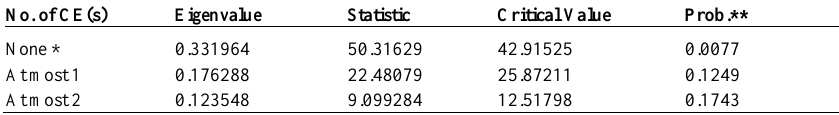
Table 7. Co-integration test of the series ln (D), ln (INC), and ln